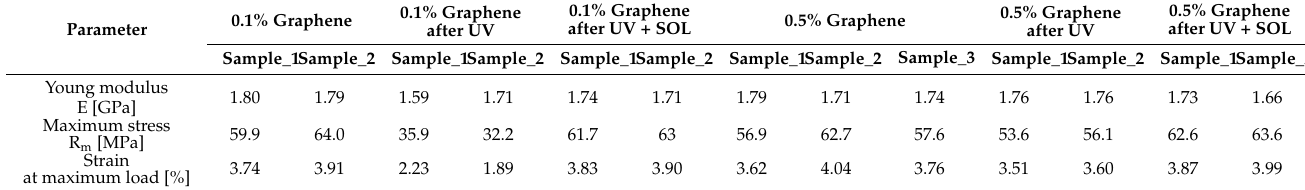
Figure 9. The curves of tensile tests for samples 4032D admixed with graphene at 0.1 wt.% ( a ) and 0.5 wt.% ( b ).